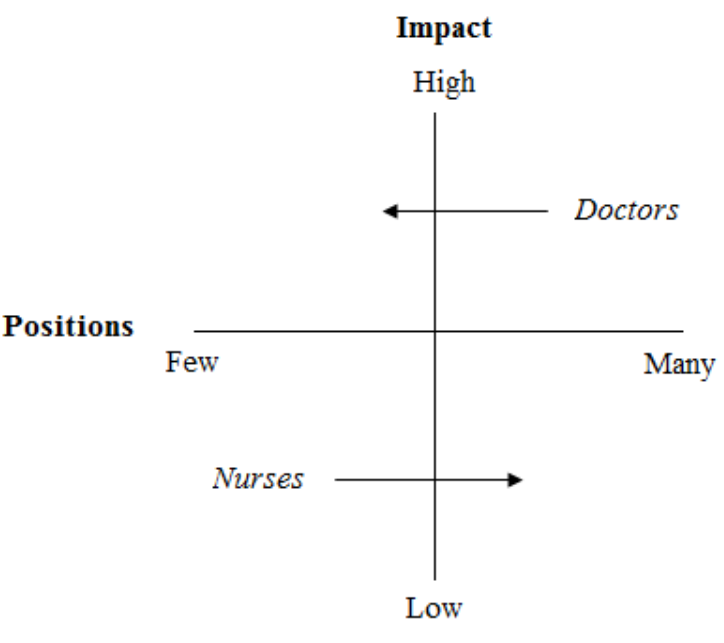
Figure 2. Change of professional impact in